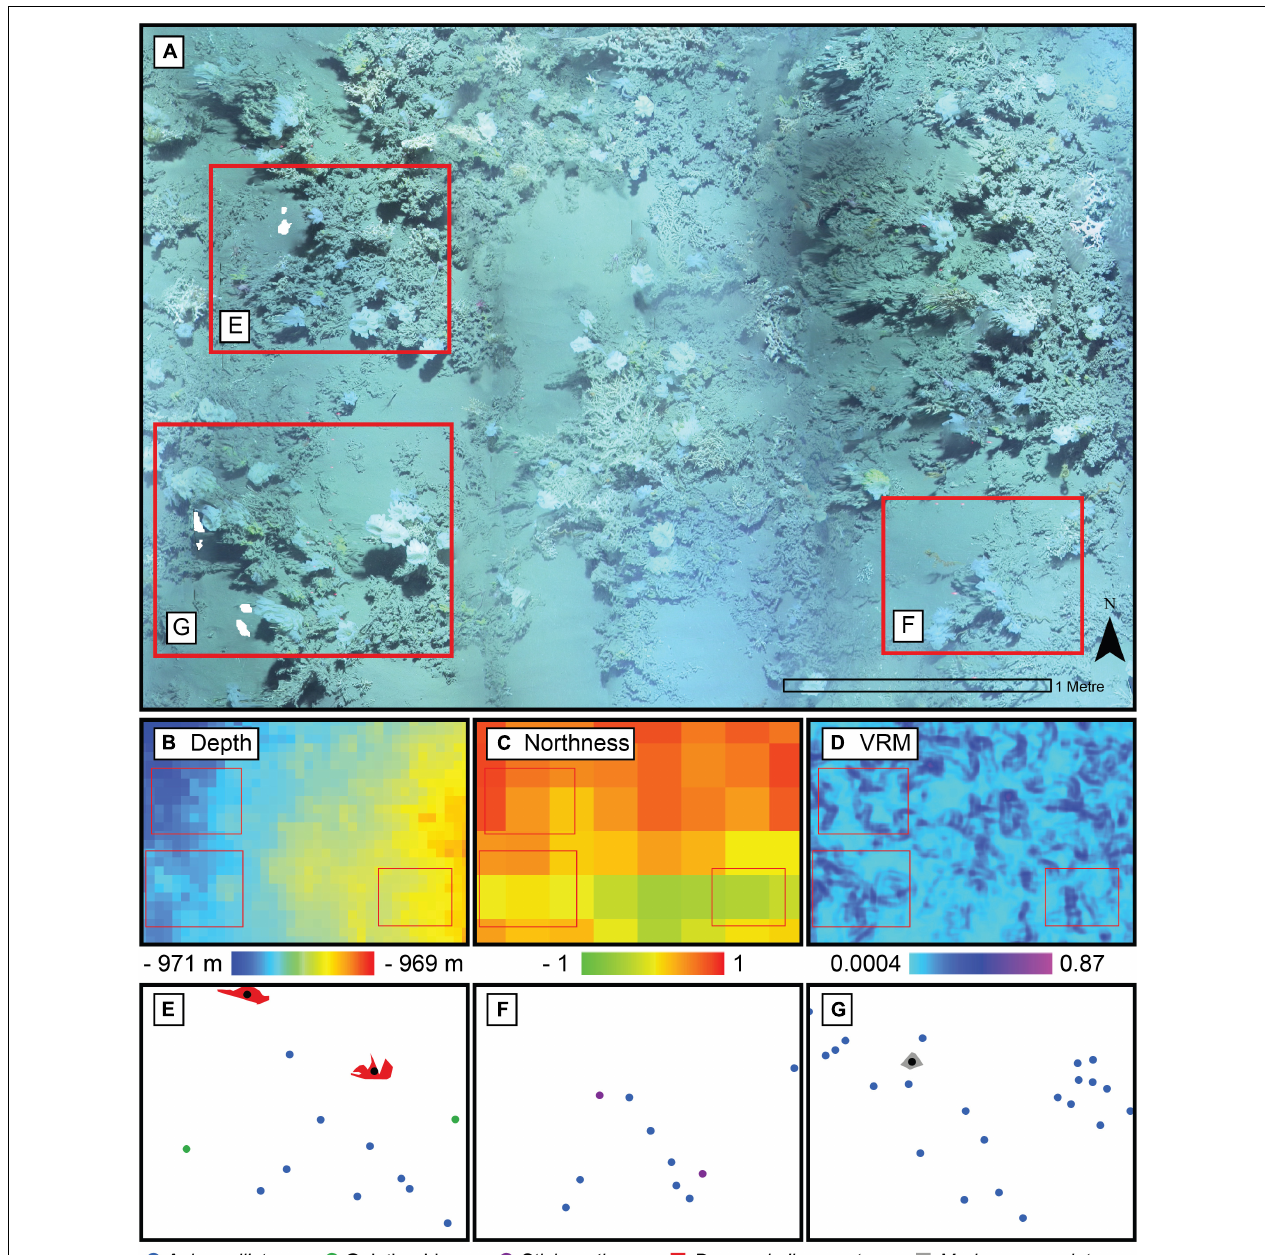
FIGURE 6 | Close up of the photomosaic at Site B. Environmental drivers derived from the Digital Elevation Model of the same area: (B) depth, (C) northness, and (D) Vector Ruggedness Measure (VRM) at 7 mm pixel with 15 pixel neighbourhood. Corresponding point patterns of species generated by geotagging each relevant individual is depicted in panels (E–G) with their respective inset marked in red in panel (A)